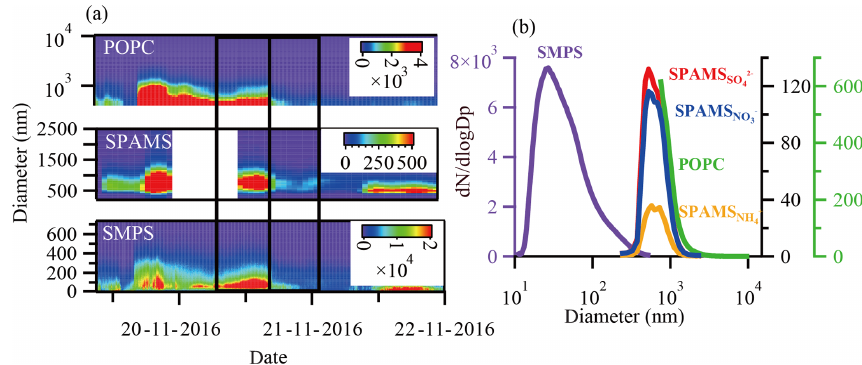
, for example) and SMPS, respectively. 4